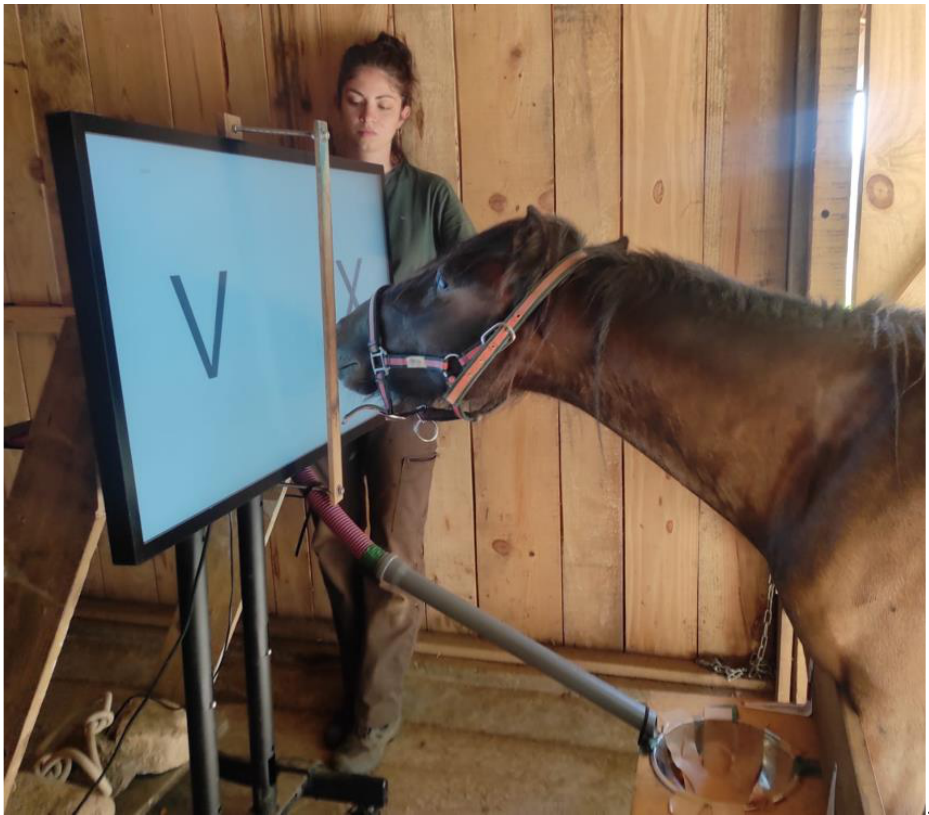
Figure 2. Experimental setup. A touchscreen (touch panel and display) displays the stimuli and automatically detects the nose/mouth touch by the horses. The touchscreen was divided into two halves. The left-right sides of the screen were separated by a 4-cm thick wooden barrier fixed 8 cm in front of the screen. Thus, the horse was allowed to touch either the left or right stimulus, but not both. Here, the horse is about to touch the letter “X” (S-) on the right half of the touch panel; the letter “V” (S+) is on the left half of the screen. Therefore, this is an example of an error trial. Horses were free to participate or quit the experiment at any time: the lead rope was disconnected from the halter once in the testing area. However, entering the stall was prevented by a 70-cm high wooden barrier (see above); the horse responded by extending his/her neck over the barrier and his/her head toward the screen. The reward was delivered manually through a tube and landed in a bowl below the touch panel in front of the horse (see Supplementary Videos S1 and